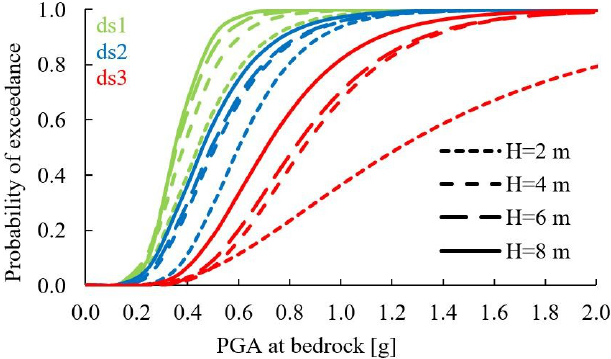
Figure 8. Influence of embankment height on fragility curves (damage state criteria for railway embankments).